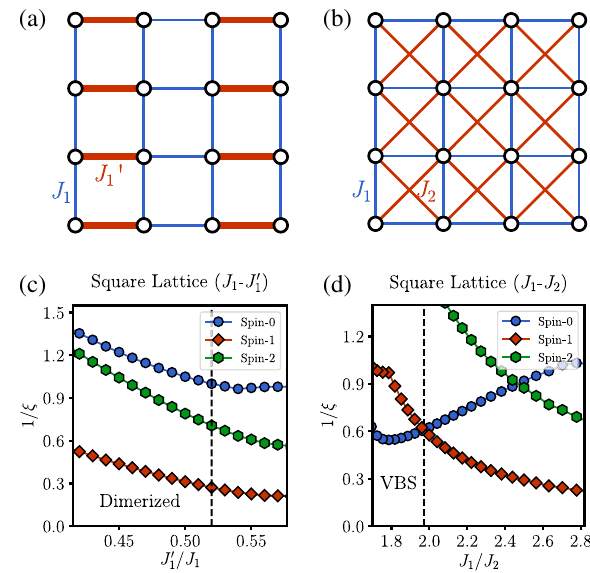
FIG. 14. (a) Square lattice J 1 - J 0 1 model with a dimer coupling J 0 1 . J 0 1 explicitly breaks the square lattice symmetry. (b) Square lattice J 1 - J 2 model. (c),(d) Correlation length spectra for the model in